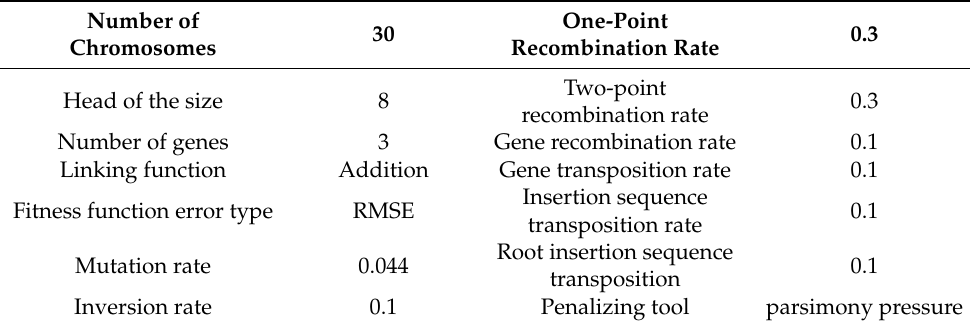
Table 2. Parameters used per run of gene expression programming